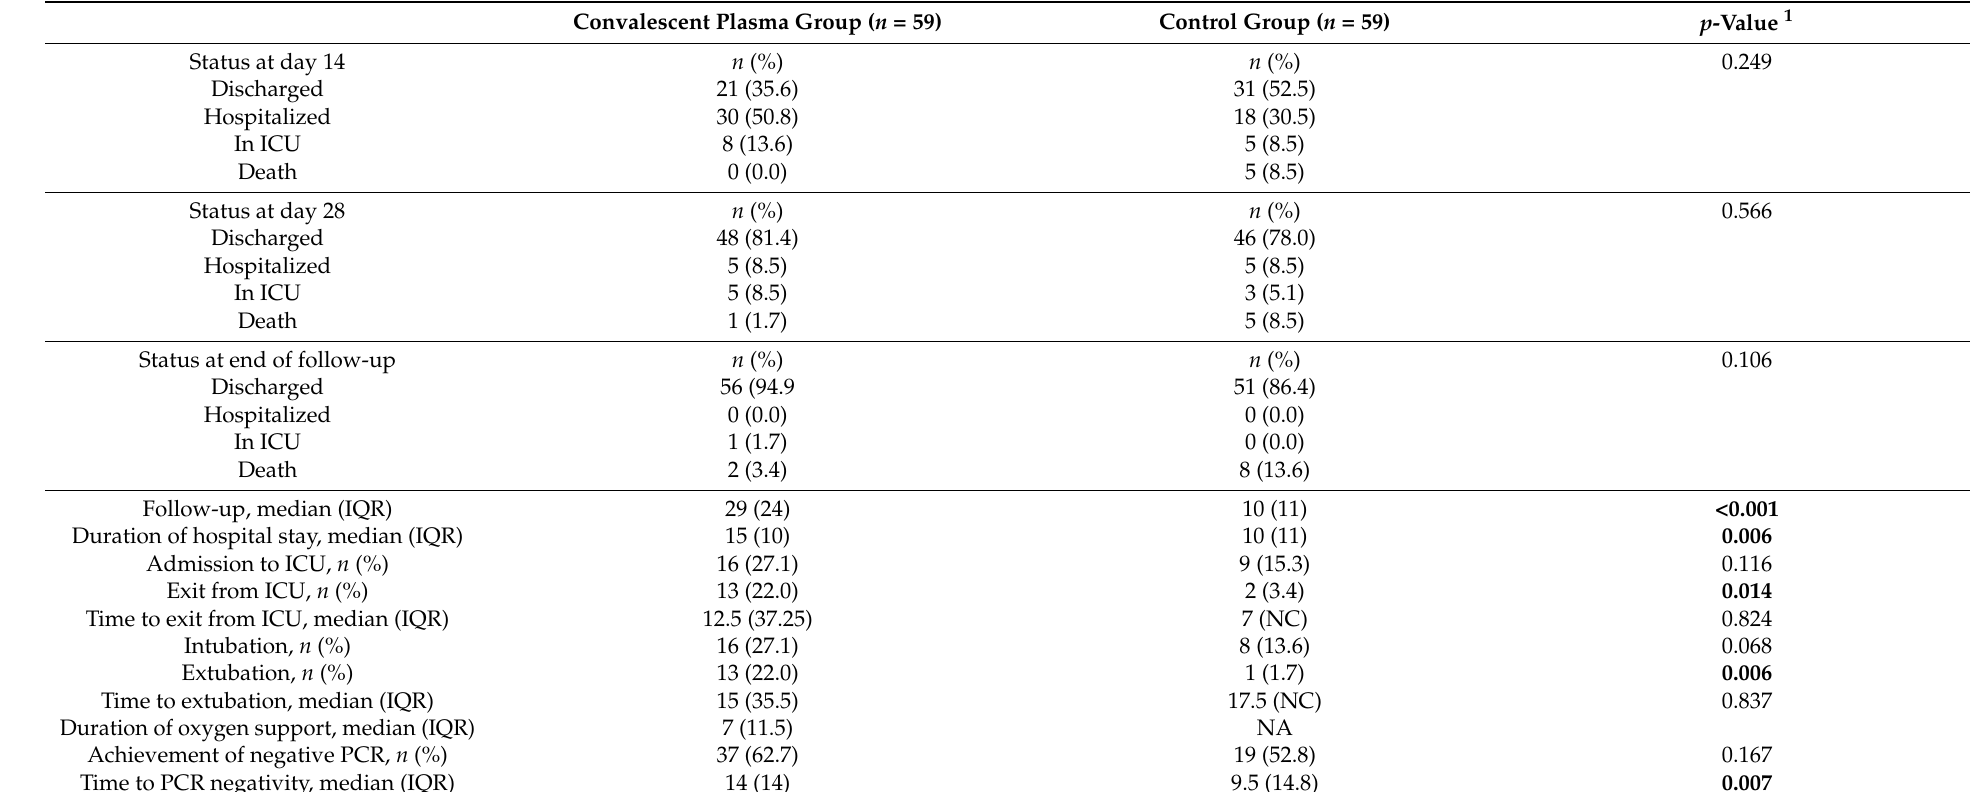
Table 2. Comparison of outcomes of patients in the convalescent plasma and the control